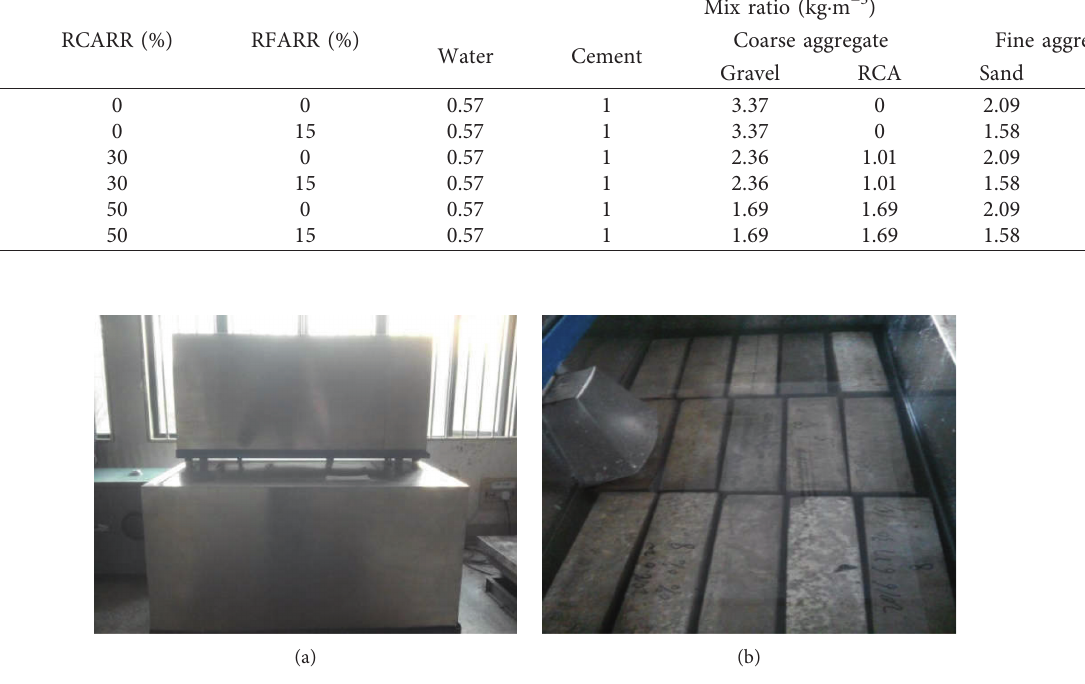
Figure 3: Dry and wet concrete test. (a) Dry and wet concrete circulator. (b) Dry and wet